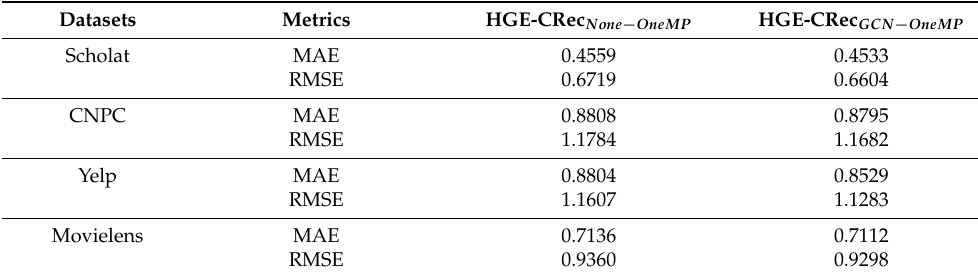
Table 9. Results of meta-path embedding